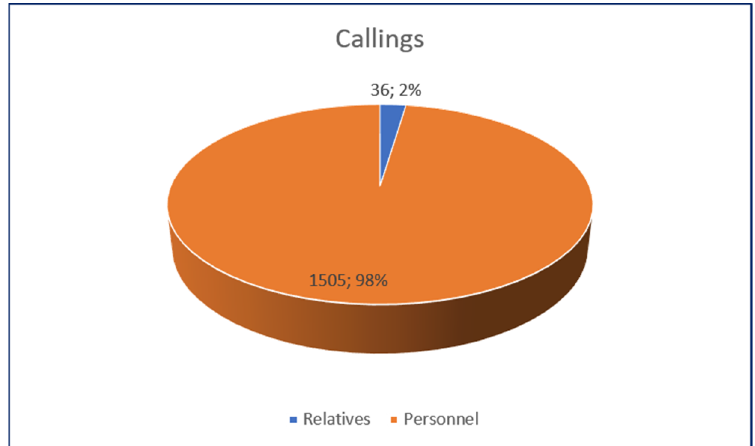
Figure 6. Calls for anointings.